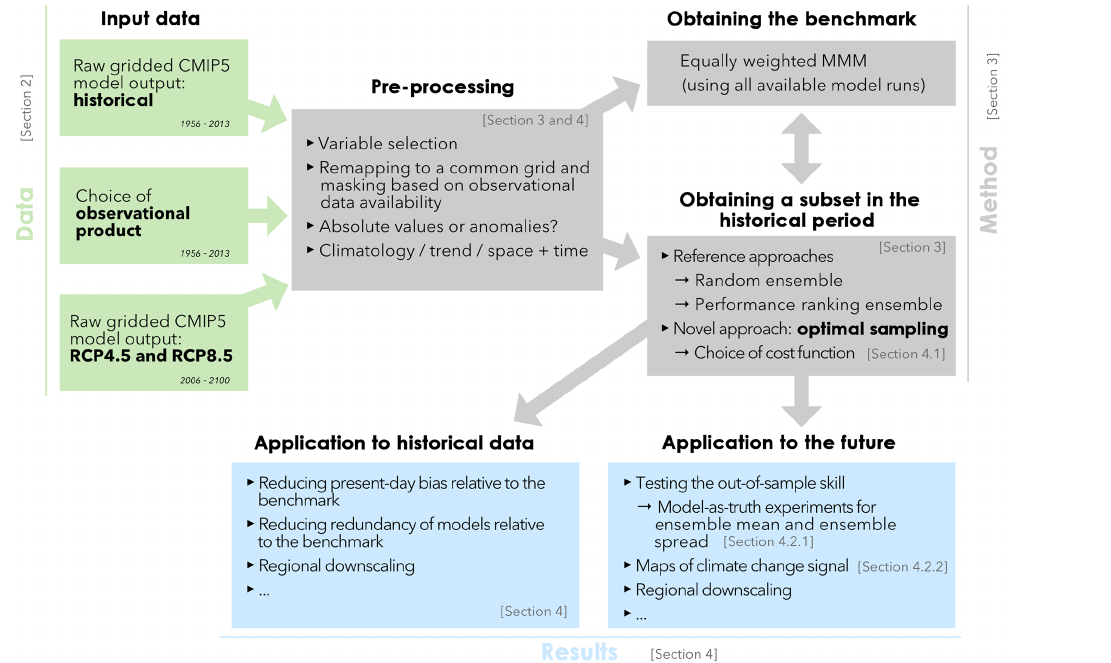
Figure 3. Graphical representation of the method for this study and its flexibility. The different colours are used for three sections in this publication: Data, Method, and